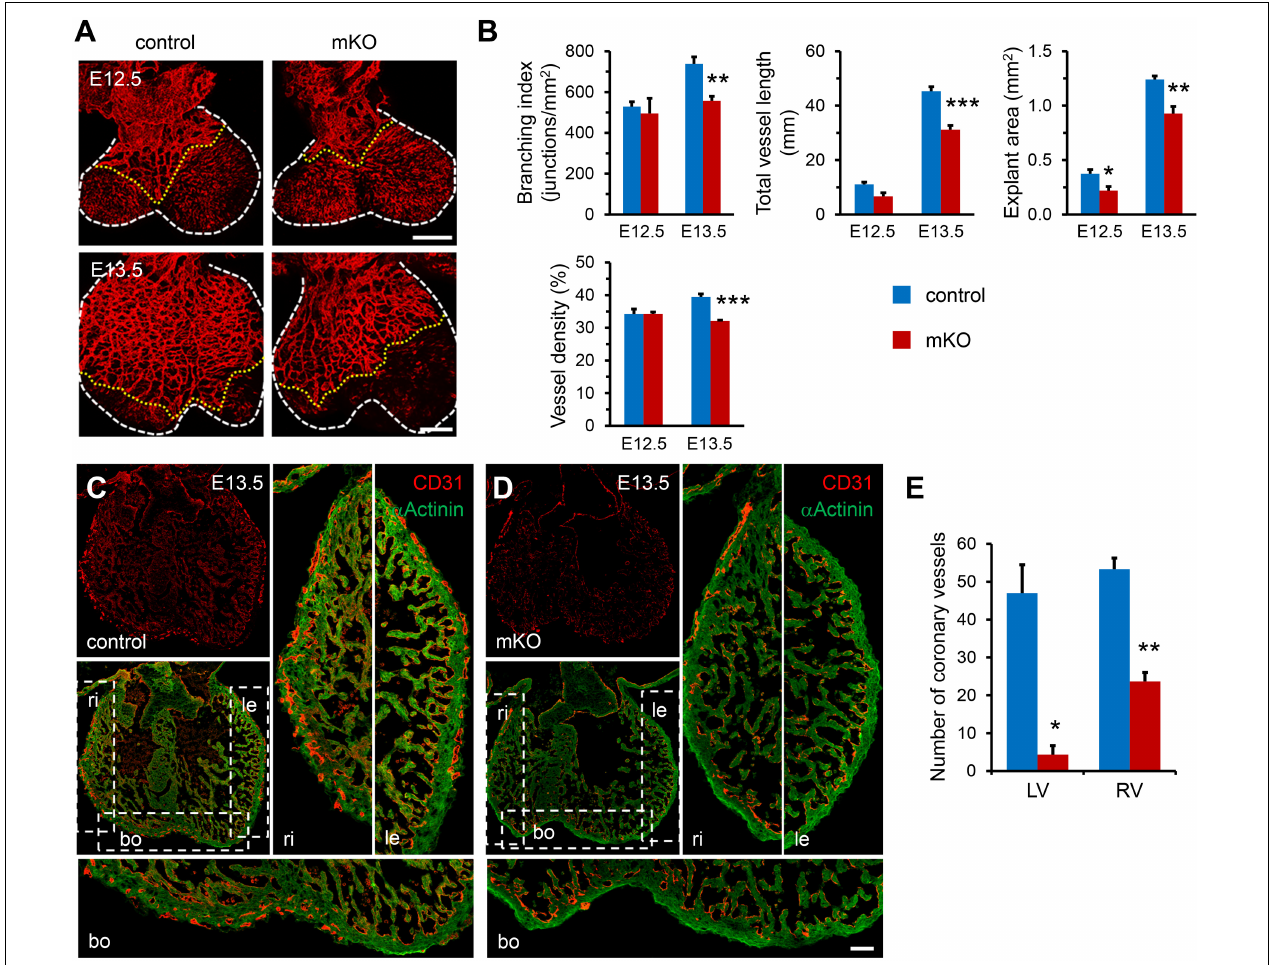
FIGURE 2 | Loss of SETD2 causes defects in coronary vascular development. (A) Whole-mount PECAM1 immunostaining of control and mKO embryonic hearts at E12.5 and E13.5. Scale bar, 500 µ m. White dotted line indicates the border of heart. Yellow dotted line indicates the leading tips of coronary vessels. (B) Quantitative analysis of coronary vessels including branching index, total vessel length, explant area, and vessel density in control and mKO embryonic hearts at E12.5 and E13.5. n = 3 for each group at E12.5, n = 5 for each group at E13.5. All data represent mean ± SEM. Significance was determined by two-tailed, unpaired Student’s t test. * p < 0.05, ** p < 0.01, *** p < 0.001 versus control. (C,D) Immunostaining analysis of coronary vessel’s distribution in control (C) and mKO (D) hearts at E13.5. Hearts were sectioned and stained with anti- α -actinin antibody for cardiomyocytes and anti-CD31 antibody for coronary vascular endothelial cells. Scale bar, 40 µ m. Ri, right ventricle. Le, left ventricle. Bo, bottom. (E) Quantification of the number of coronary vessels in left (LV) and right ventricles (RV) of control and mKO hearts at E13.5, respectively. n = 5 for each group. All data represent mean ± SEM. Significance was determined by two-tailed, unpaired Student’s t test. * p < 0.05, ** p < 0.01 versus